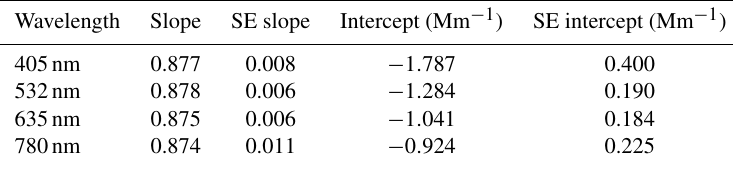
Table 2. Deming regression parameters of PP vs. PaM calculations at different